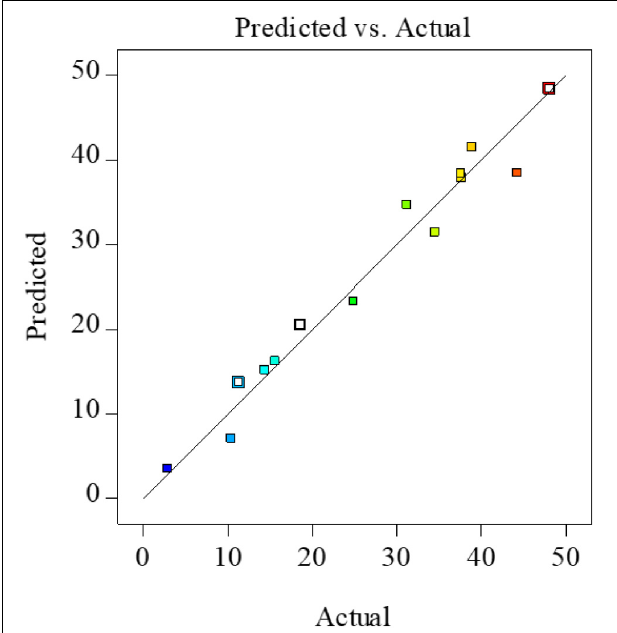
FIGURE 2 | Actual vs. predicted XOS yields from FA hydrolysis of xylan. XOS, xylooligosaccharides; FA, furoic acid.